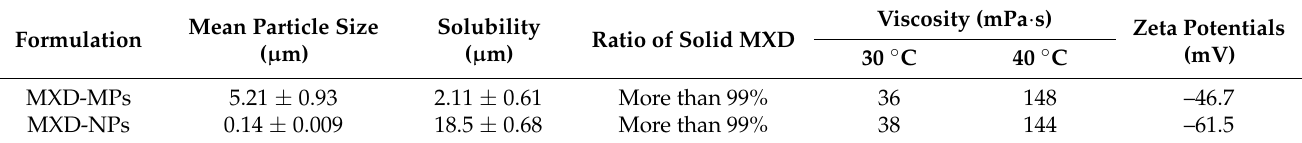
Table 1. Characteristics of MXD-MPs and